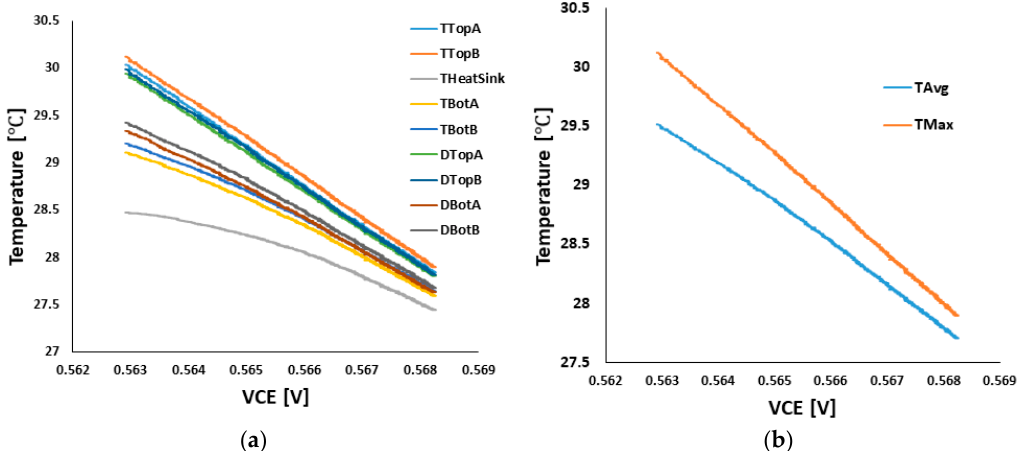
Figure 4. ( a ) Measured temperatures in cool-down phase; ( b ) Calibration curves determined from maximum and average of measured temperatures.